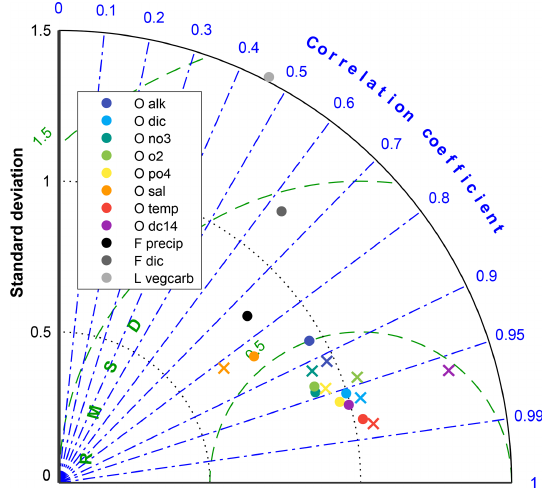
Figure 10. Taylor diagram (Taylor, 2001) of multiple global UVic ESCM 2.10 fields (dots) and the UVic ESCM 2.9 fields ( × ) with re- spect to re-gridded observations from the World Ocean Atlas 2018 (Locarnini et al., 2018; Zweng et al., 2019; Garcia et al., 2018a, b), Global Ocean Data Analysis Project (GLODAP) and GLODAP mapped climatologies v2.2016b (Key et al., 2004; Lauvset et al., 2016), NASA-GSFC precipitation (Adler et al., 2003), air–sea gas fluxes from Takahashi et al. (2009), and vegetation carbon data from the CDIAC NDP-017 dataset (Olson et al., 2001). All datasets are normalized by the standard deviation of the observations. A perfect model with zero root mean square deviation, a correlation coeffi- cient of 1 and a normalized standard deviation of 1 would plot at